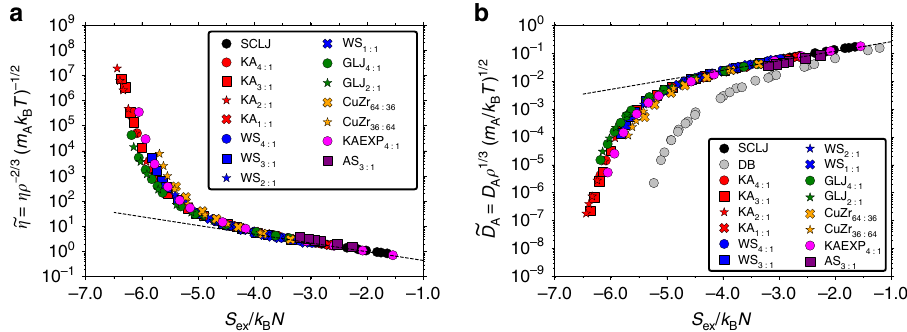
Fig. 3 Reduced viscosity and A-particle diffusion coef fi cient as a function of S ex for all mixtures and compositions. A quasiuniversal curve is observed in both cases with excess entropy. The black dashed lines give Rosenfeld single-component quasiuniversality Eq. (1). a Reduced viscosity e η as a function of S fi cient e D S 26 ) give reference data for an almost ex . b Reduced A-particle diffusion coef ex . The grey data points (DB, data taken from ref. A as a function of sphere-like dumbbell molecule that is easily supercooled; in this case no quasiuniversality is found. In comparison, the observed deviations between the different binary mixture data are relatively small.